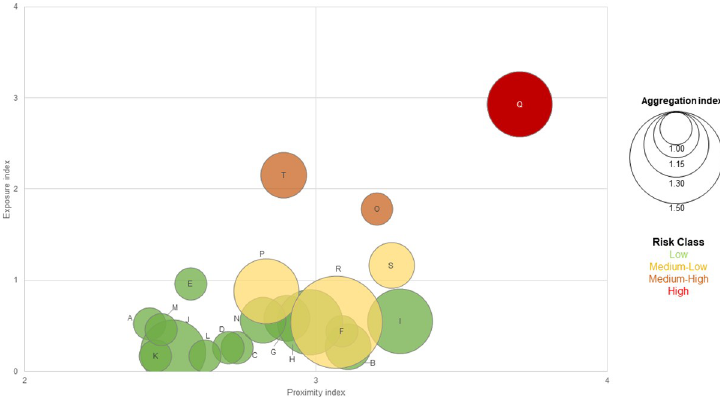
Fig 1. Risk class per employment sector. Low R < 2; Medium-Low 2 � R < 4; Medium-High 4 � R < 8; High R � 8.